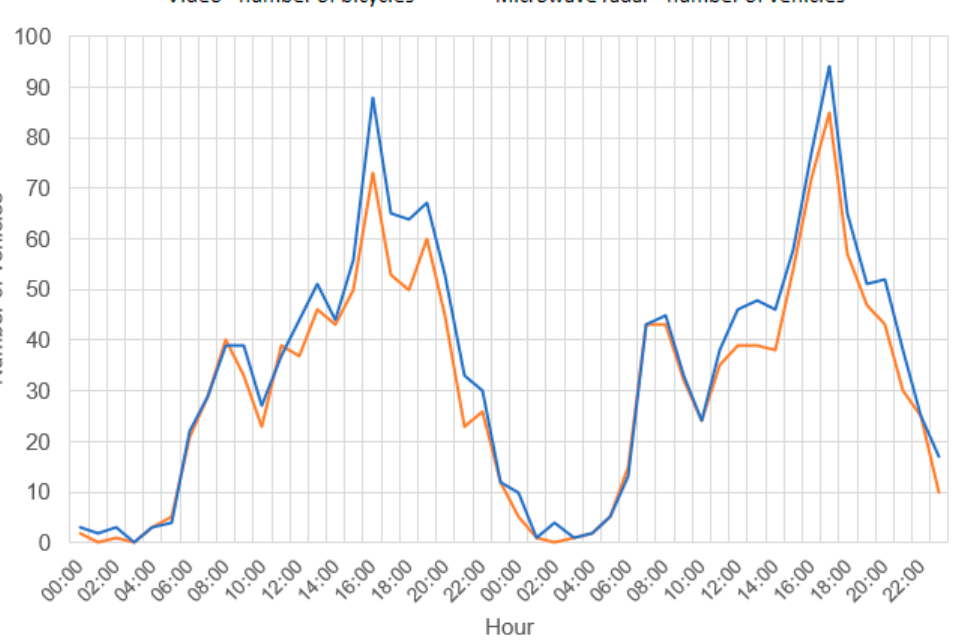
Figure 9. Comparison of the number of vehicles recorded by the microwave radar with the actual number of bicycles (the measuring station at Ś wi ę tokrzyska street) (own study).